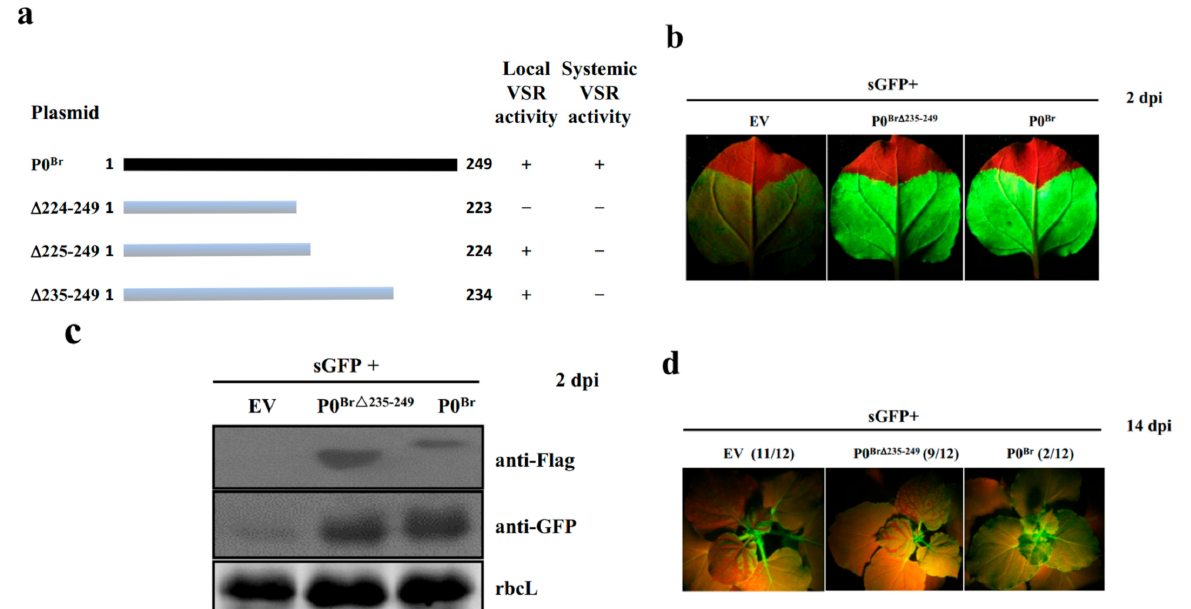
Figure 1. Verification of P0 Br ∆ 235–249 VSR activity. ( a ) Schematic representation of P0 Br and P0 Br trun- cated mutants used to screen for a suitable region that abolished RNA-silencing suppressor activity. +: Retained; − : Abolished. ( b ) Analysis of local RNA-silencing suppression of P0 Br ∆ 235–249 . GFP was expressed in co-infiltrated wild-type N. benthamiana leaf patches at 2 dpi under UV illumination. The left sides of leaves are expressing GFP of EV (negative control), the right sides are expressing GFP of wild-type P0 Br (positive control). ( c ) Western blotting analyses of GFP and 3Flag-tagged P0 Br or P0 Br ∆ 235–259 in co-infiltrated leaf patches of N. benthamiana using a GFP polyclonal antibody (anti-GFP) and a Flag monoclonal antibody (anti-Flag), respectively. Stained rubisco is shown to indicate equal lane loading. ( d ) Analysis of systemic RNA-silencing suppression by P0 Br ∆ 235–249 . GFP was expressed in the upper leaves of co-infiltrated N. benthamiana line 16c plants at 14 dpi under UV illumination. The numbers denote silencing plants with the total number of plants